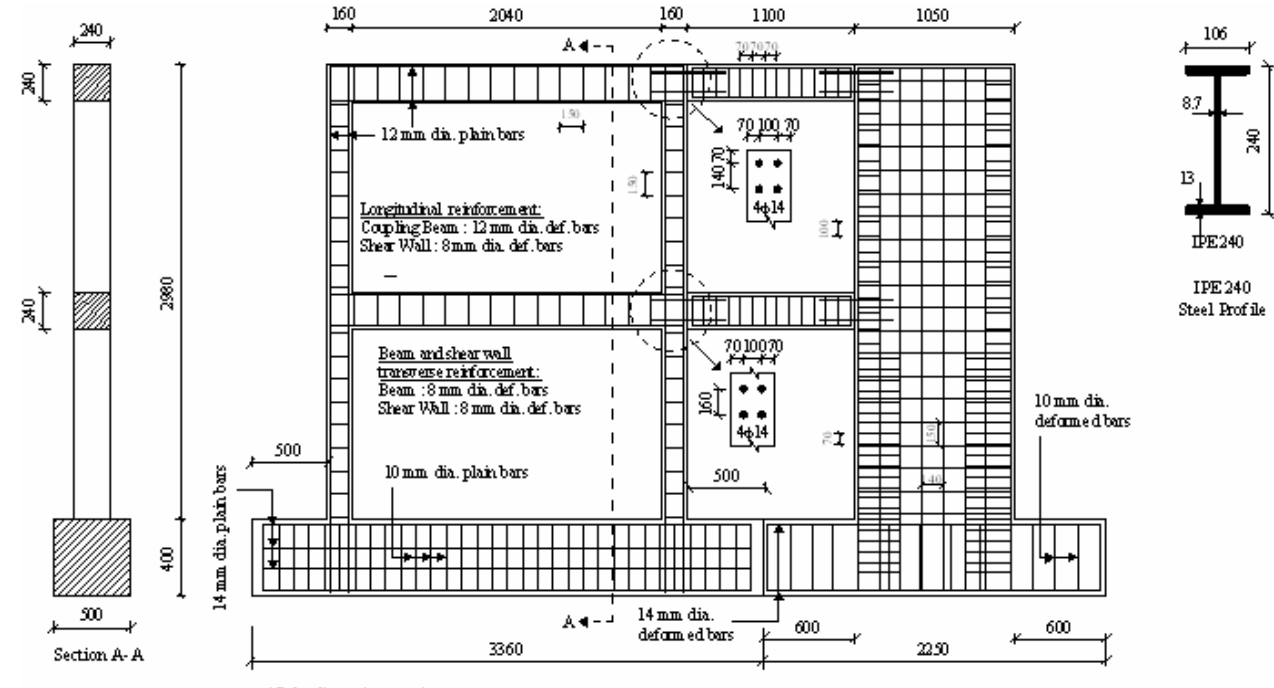
Figure 6. Dimensions and reinforcement schemes of the RC frame and external shear wall of the 2 nd group tests